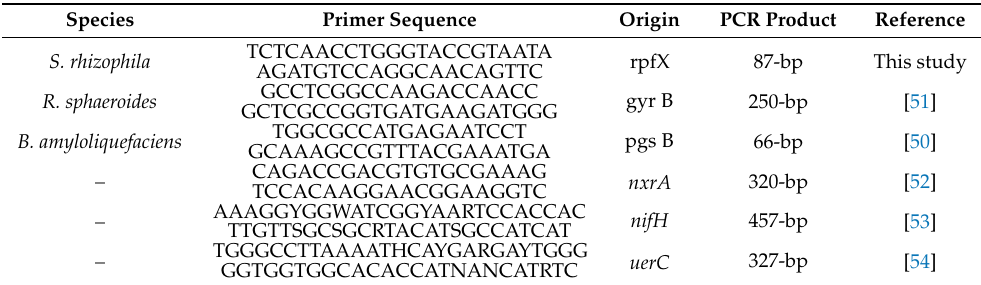
Table 1. Quantification PCR primers of the PGPR.